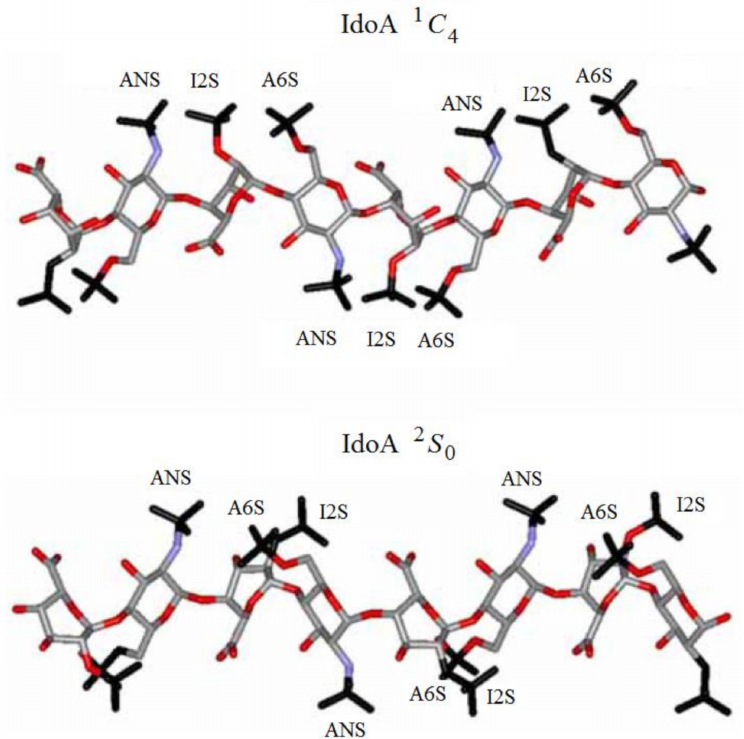
Figure 32. Structural differences of heparin chains associated with distinct conformations of iduronic acid residues. For designations on the figure, see original publication. Reproduced with minor editing privilege from Guerrini [142] with the permission of Bentham Science Publishers Ltd.